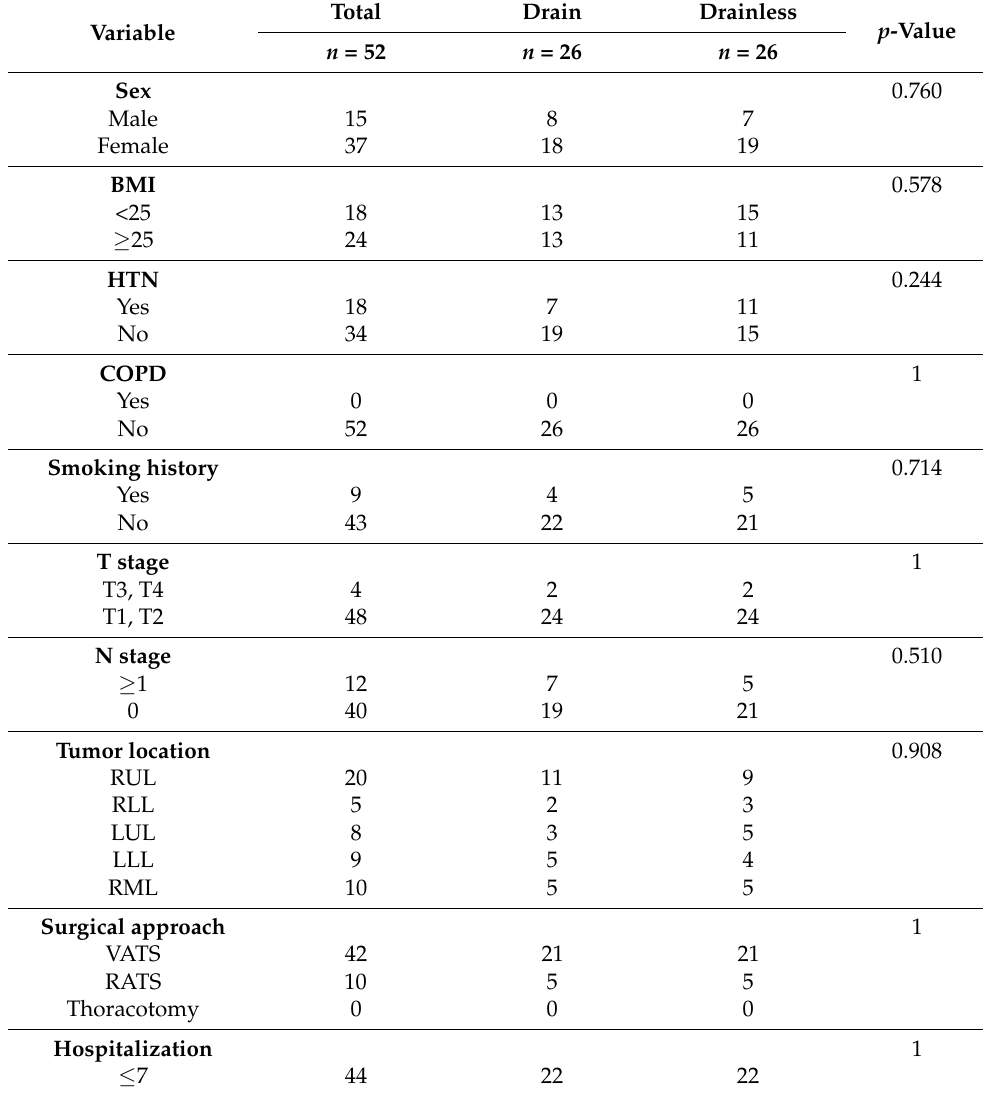
Table 2. Characteristics of patients in the drain and drainless groups after propensity score